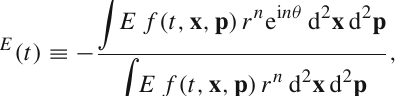
Fig. 7 Time evolution of the spatial eccentricities in a collisionless system. The top panel shows particle-number weighted eccentricities ε x , ε x ,thebottompaneleccentricities ε x , E , ε x , E withenergyweighting. 2 3 2 3 The dotted curves are fits with Eq. (18) and the parameters given in Table 1 ( t ) and harmonic, a 3 takes the respective values 3 / 4 for ε x 3 , E ( t ) . Note that these numerical values are valid 9 / 8 for ε x 3 only for the initial distribution (7)–(10), while Eq. (18)